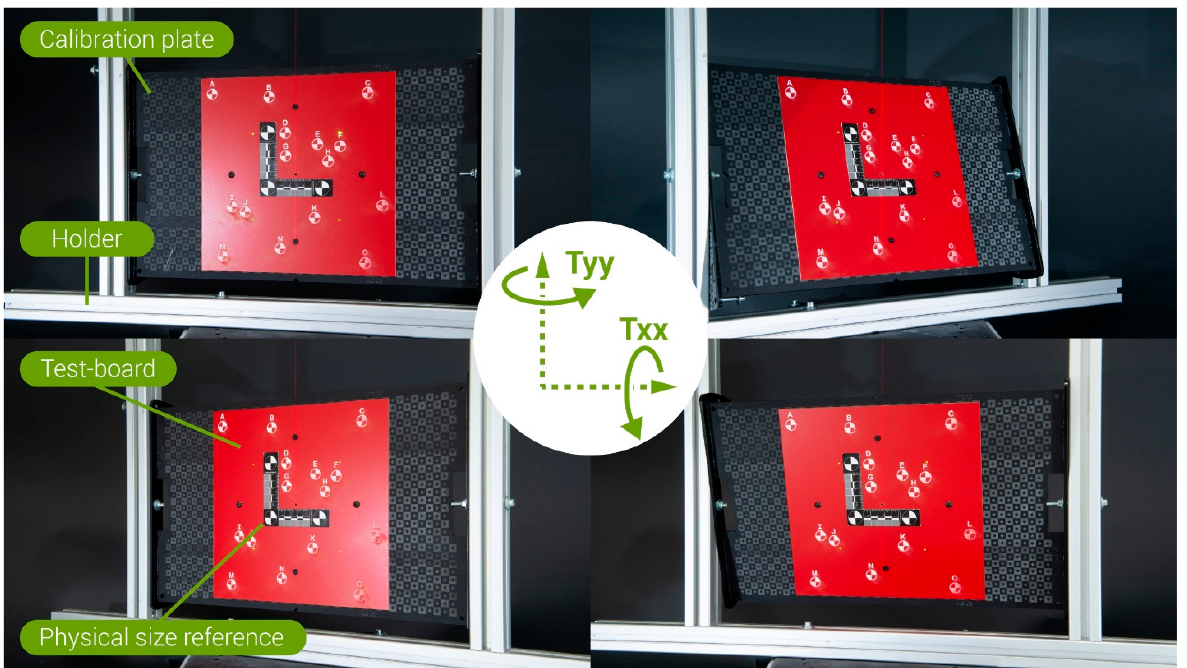
Figure 9. Four arbitrary examples of the S-mode photos with the test board used in the user tests.